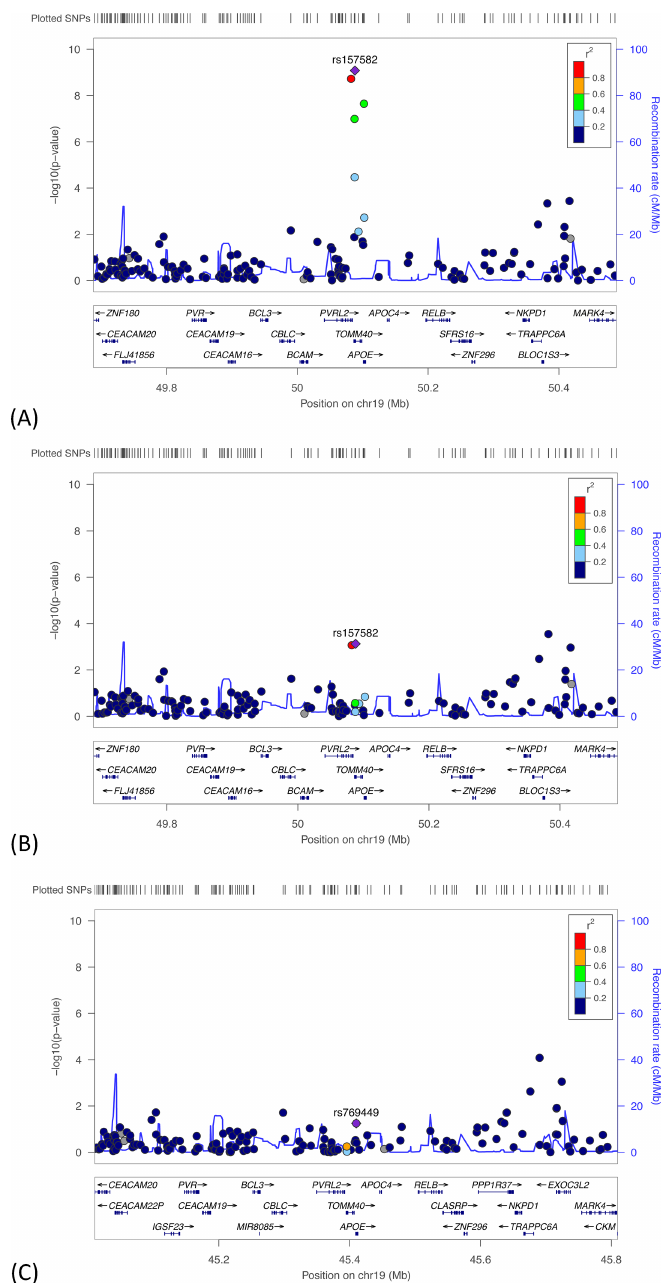
Fig 5. Regional plots showing results of the meta-analyses of IR-C. (A) Meta-analysis results with the top SNP in TOMM40 (rs157582)shown; (B) results when estimatingthe associationwith the TOMM40 SNP shown (rs157582), conditioning on the top APOE SNP (rs769449); and (C) results when estimating the association with the APOE SNP (rs769449), conditioningon the top TOMM40 SNP (rs157582). The y-axis shows -log 10 P-values; x-axis shows positionof genes on chromosome 19 with SNPs 400-kbin both directions of the SNP of interest. The diamondrepresents the top SNP of interest. The circles represent each genotyped SNP in this region; the circle color indicatespairwise linkagedisequilibrium (LD) in relationto the top SNP (calculated from hg19/1000Genomes Nov 2014 EUR). The solid (blue) line indicatesthe recombination